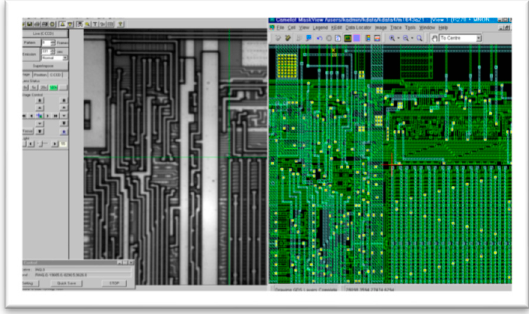
Figure 9. Image Overlay in Avalon.